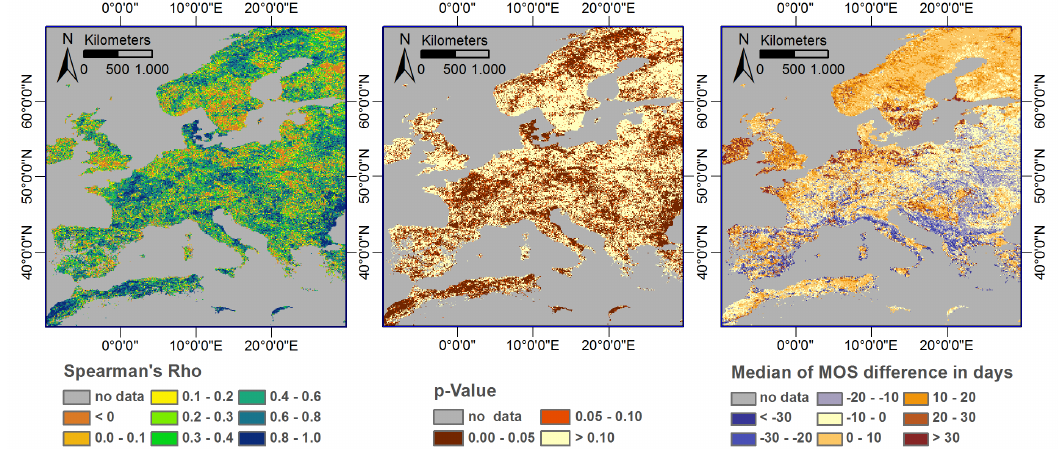
Figure 18. Correlation (at pixel level) between the maximum of season (MOS) from GIMMS, respectively, MODIS time series. The rank correlation coefficient is shown on the left whereas the corresponding p-value is shown in the center. The median of differences (in days) is shown on the